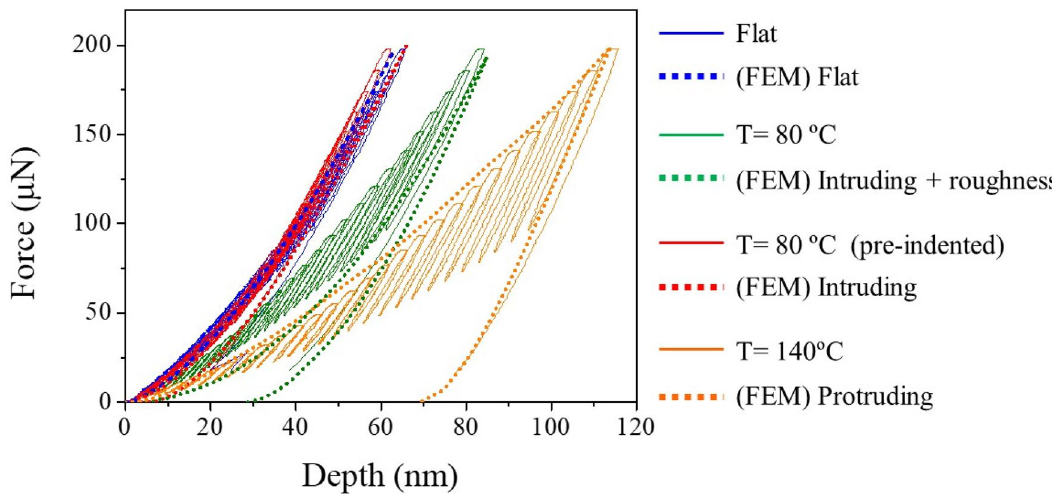
Figure 11. Finite element simulated load–displacement curves (dotted lines) obtained for the flat, inverted nanocone (with and without roughness) and protruding moth-eye nanostructure. The simulated curves are compared with the experimental load–displacement curves (continuous lines) of the corresponding nanostructures obtained at different temperatures and web speed of 0.02 m·min −1 . In the case of the sample processed at 80 °C a curved obtained after sample preindentation is additionally